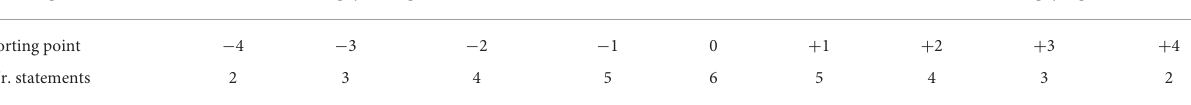
TABLE 1 Features of the sorting grid.